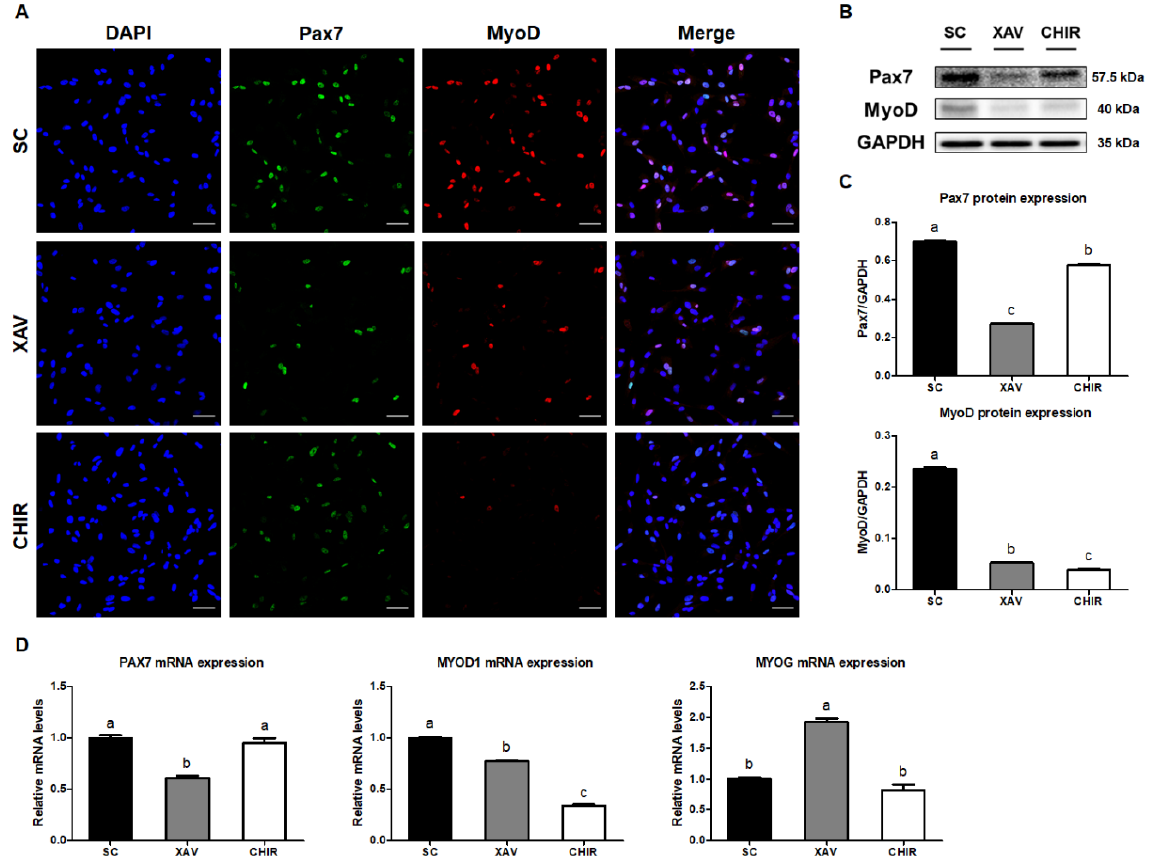
Figure 2. Expression of transcription factors Pax7 and MyoD in PMSCs by addition of Wnt signaling pathway regulators. ( A ) Immunostaining images of PMSCs. Cell nuclei were stained with DAPI (blue), Pax7 (green), and MyoD (red). ( B ) Pax7 and MyoD protein levels in PMSCs. ( C ) Quantitation of Pax7 and MyoD protein levels relative to GAPDH. ( D ) Gene expression levels of PAX7 , MYOD1 , and MYOG in PMSCs. Values are presented as mean ± SE. a–c Different letters represent statistically significant differences among treatment groups ( p < 0.01). Scale bar, 50 µ m. Protein marker informa- tion used for target protein detection is presented in Supplementary Figure S2. Full-length blots are presented in Supplementary Figure